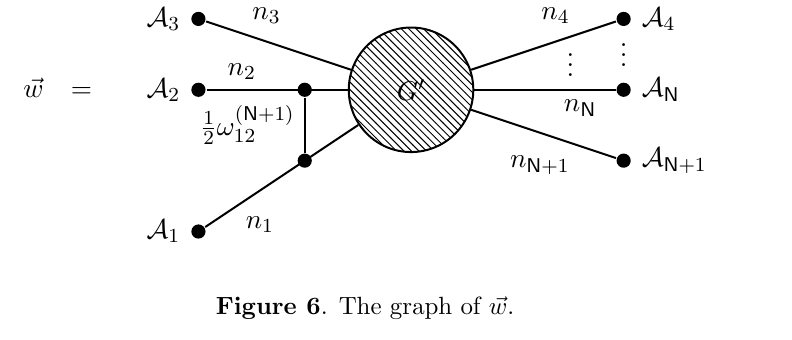
Figure 6 . The graph of ~w